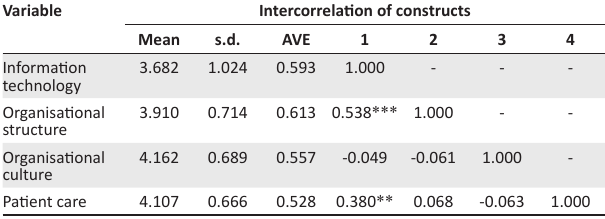
TABLE 3 : Descriptives and correlations for the